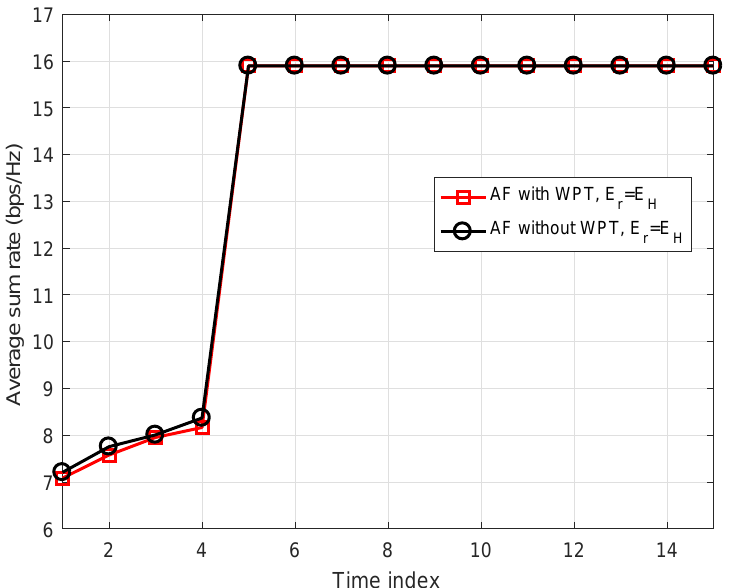
Figure 5. Average sum rate performance vs. time index when E s < E r ( N = 4, d sr = 1 m and d rd = 50 m).